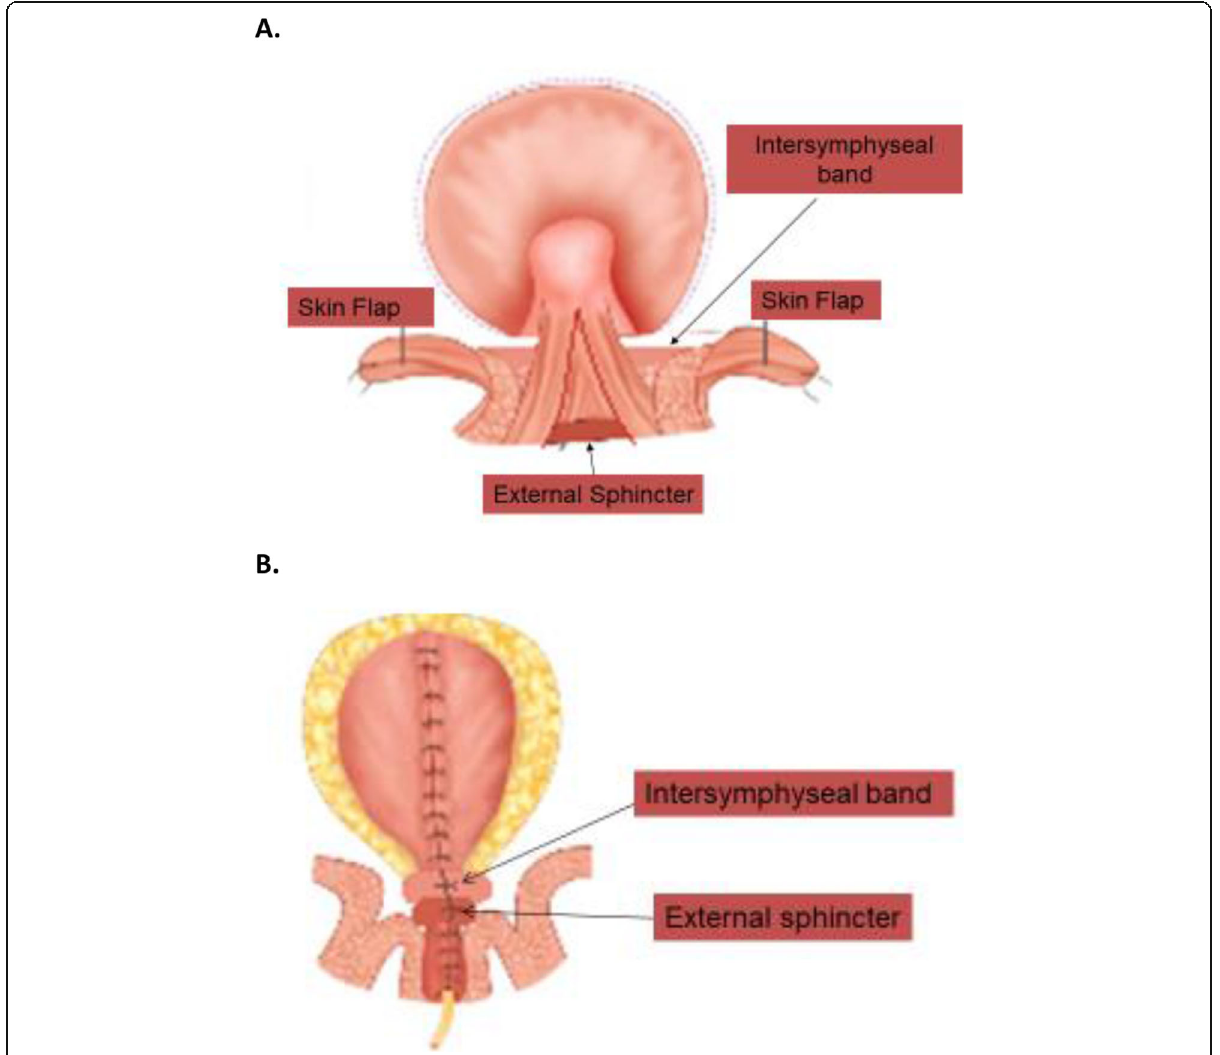
Fig. 2 a Intraoperative anatomy of internal and external sphincter. b Reconstructed sphincters in anatomical repair of bladder